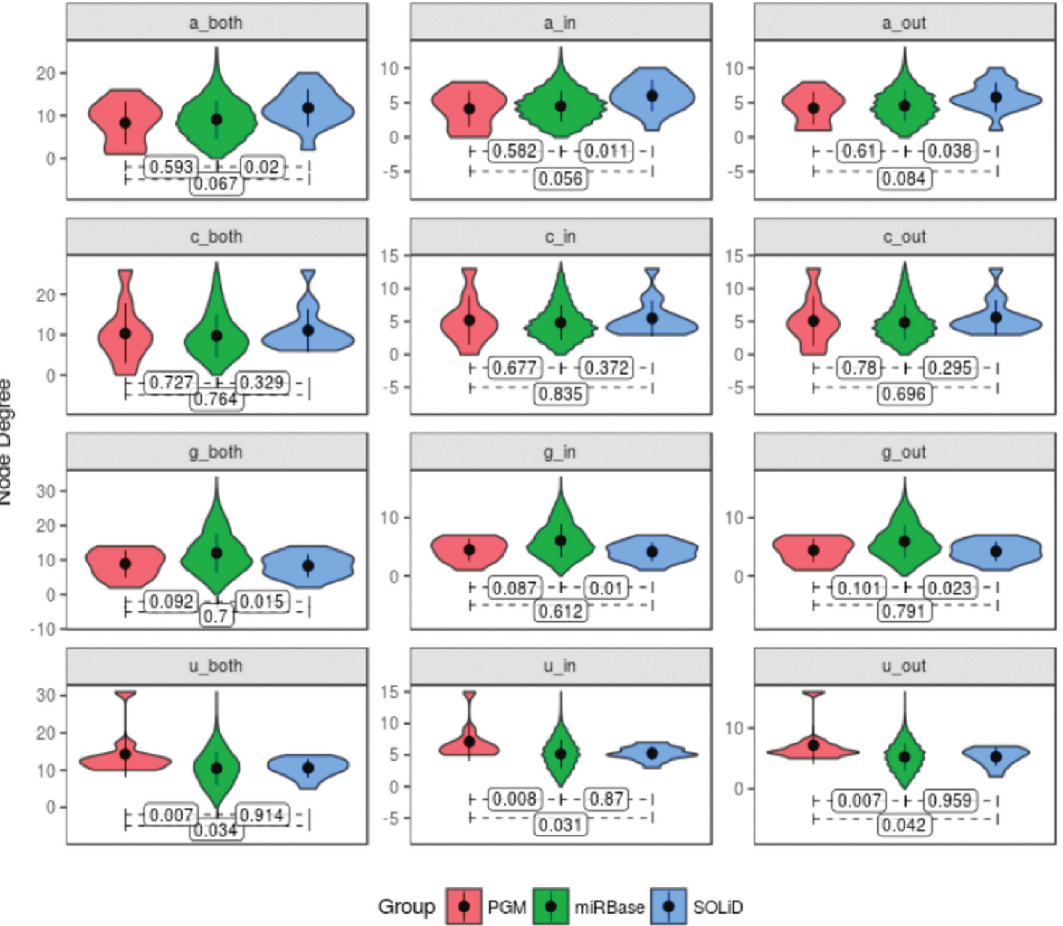
Figure 5 - P -values of Z-tests comparing average node degree of PGM and miRBase and SOLiD and miRNA sequences. Labels on X-axis describe node label (nucleotide) at prefix and edge type at